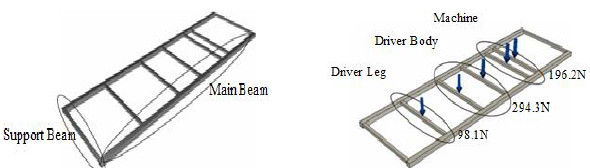
Table 4: Benchmark result of static analysis determined by